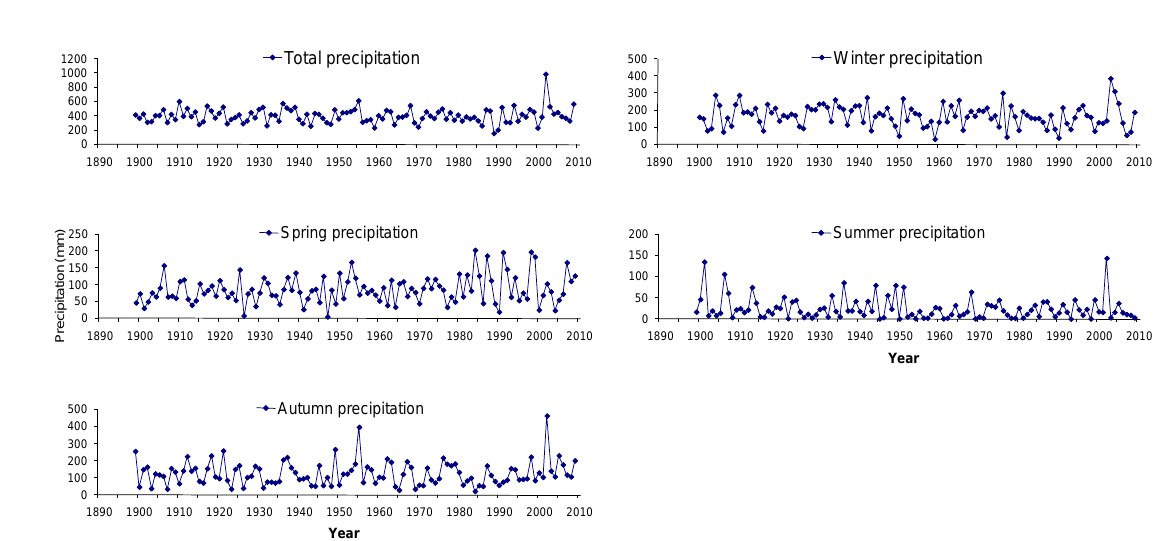
Fig. 2. Time series of historical temperature and precipitation data as acquired from the National Observatory of Athens (NOA).